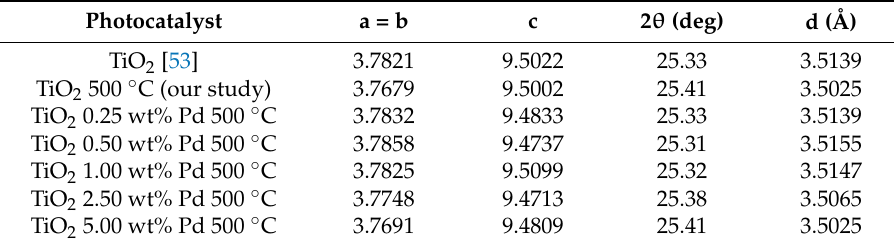
Table A2. Lattice Parameters for TiO 2 and Pd doped TiO